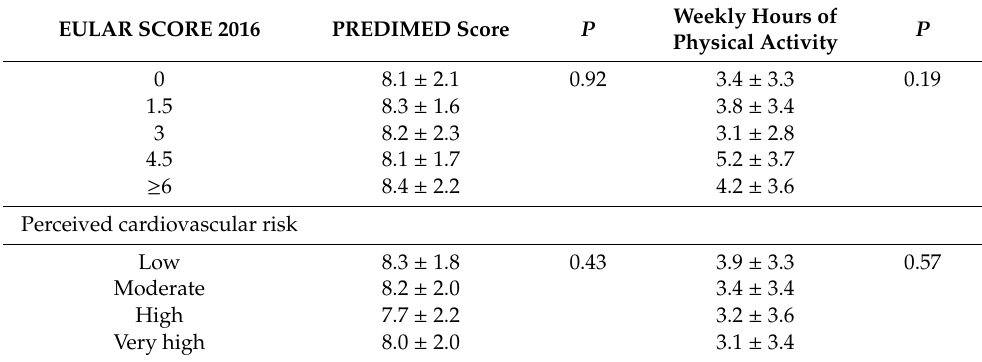
Table 6. Accomplishment of Mediterranean diet and physical exercise according to perceived and SCORE-estimated cardiovascular